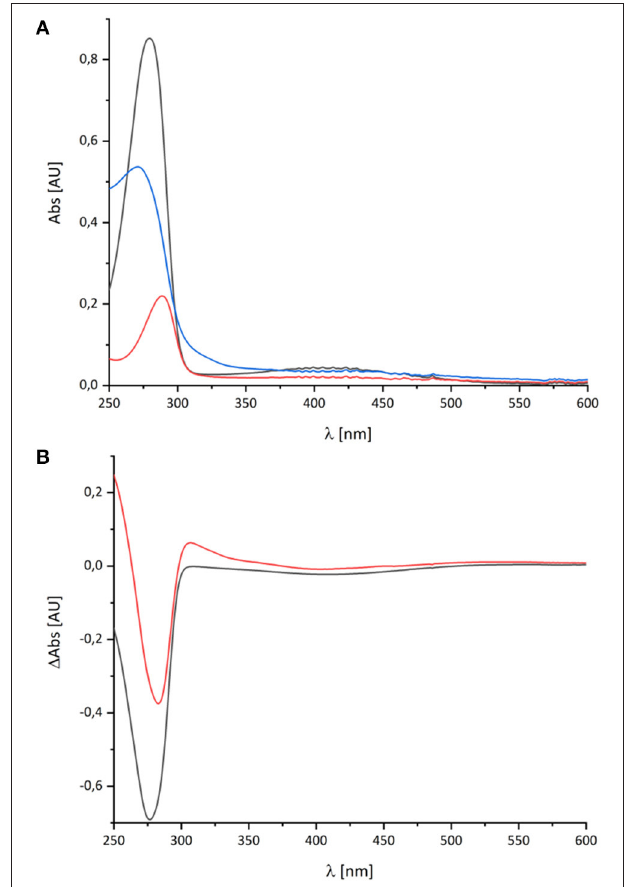
FIGURE 2 | Reduction of E. coli complex I by NADH followed by partial re-oxidation by oxygen from the air. (A) The black trace shows the absorbance of NADH at 340nm and the blue trace that of the complex I at 450nm. (B) Shows the (reduced-minus-oxidized) difference spectrum observed after 2min after the addition of NADH. Residual contributions from the two tetranuclear Fe/S clusters on NuoI at 334 and 418nm are indicated by asterisks.